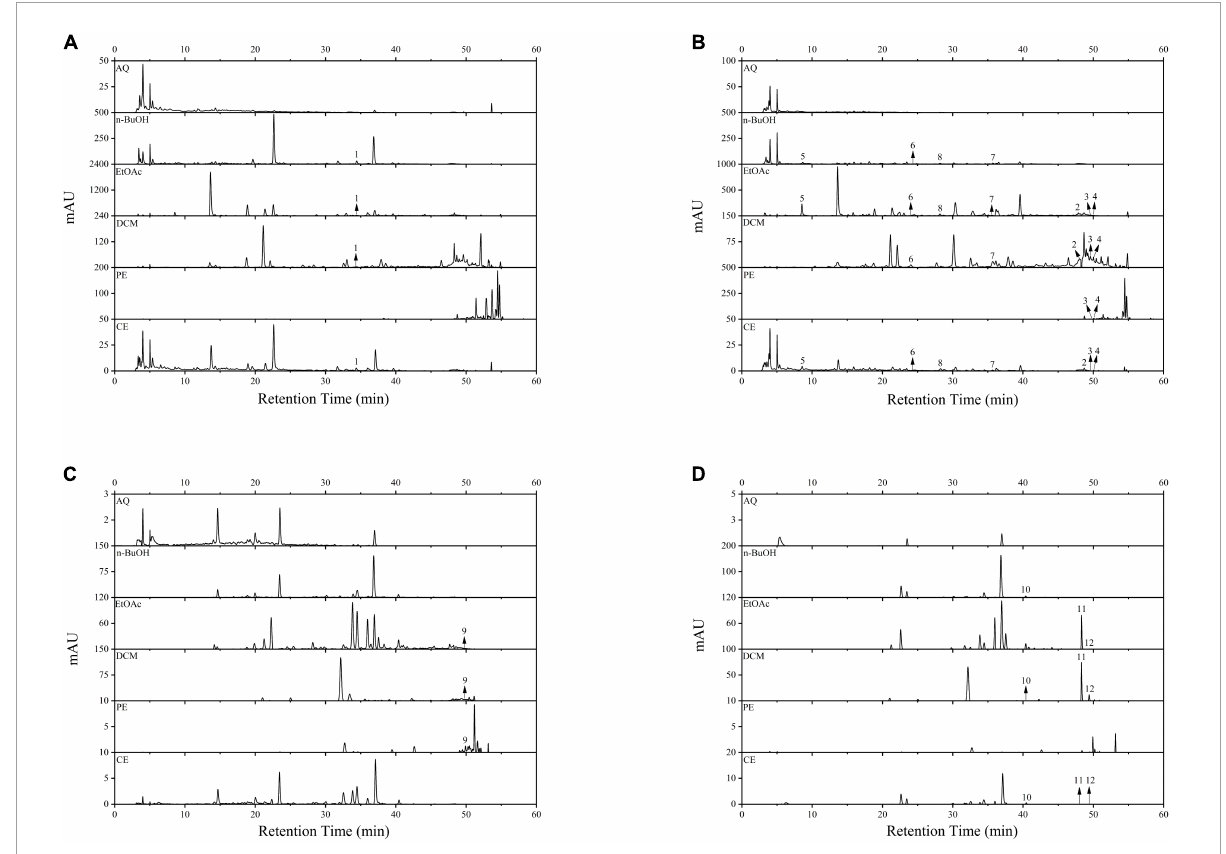
FIGURE5 The HPLC spectrum of BCF crude extract and its fractions. (A) Wavelength at 256 nm; (B) wavelength at 280 nm; (C) wavelength at 340 nm; (D) wavelength at 360 nm. 1, Rutin; 2, Resveratrol; 3, Baicalein; 4, Hesperetin; 5, Gallic acid; 6, Epicatechin; 7, (–)-Epicatechin gallate; 8, Dihydromyricetin; 9, Apigenin; 10, Myricetin; 11, Quercetin; 12, Luteolin.